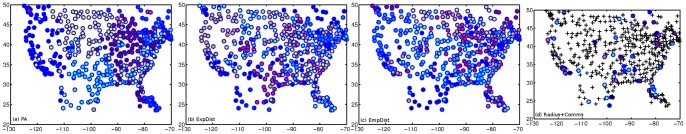
The communities detected by the different methods in the Airline network (best viewed in color).The communities identified by PA show a strong spatial structure, which is mostly maintained in ExpDist and EmpDist as well, although nodes on the fringe may switch to neighboring communities. In contrast, Radius+Comms identifies much fewer, though much more strongly integrated communities (nodes not belonging to any community are shown as black+'s) for which it is difficult to identify any real spatial structure.